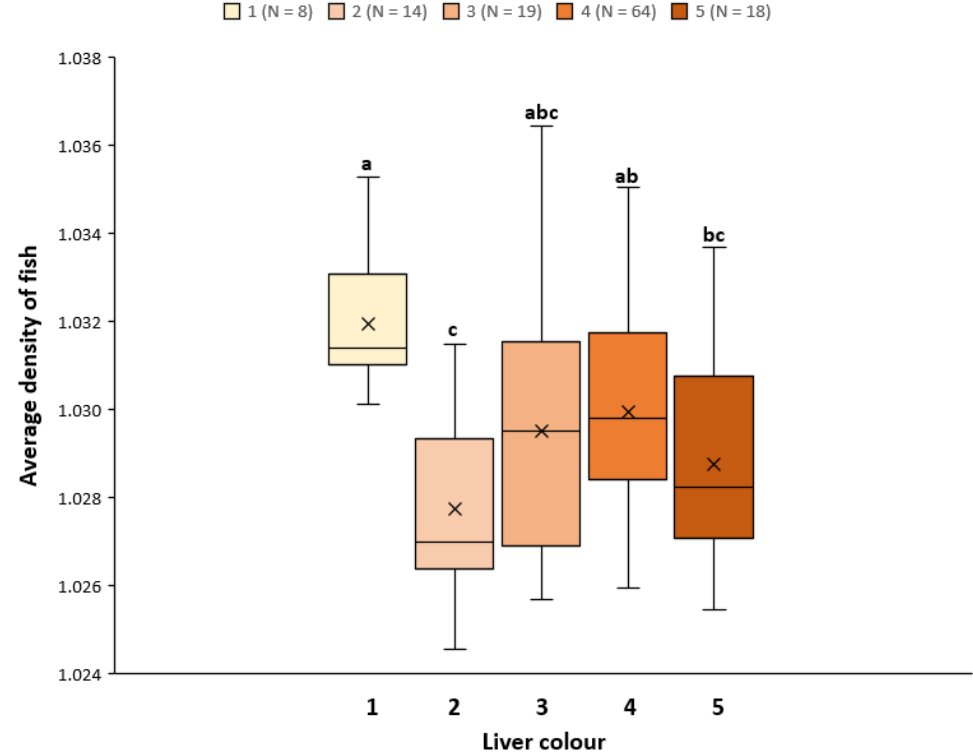
Figure 3. A scatterplot with a fit line of body density by Fulton’s K ( n = 123). Location D was excluded from the analysis (see text for explanation).